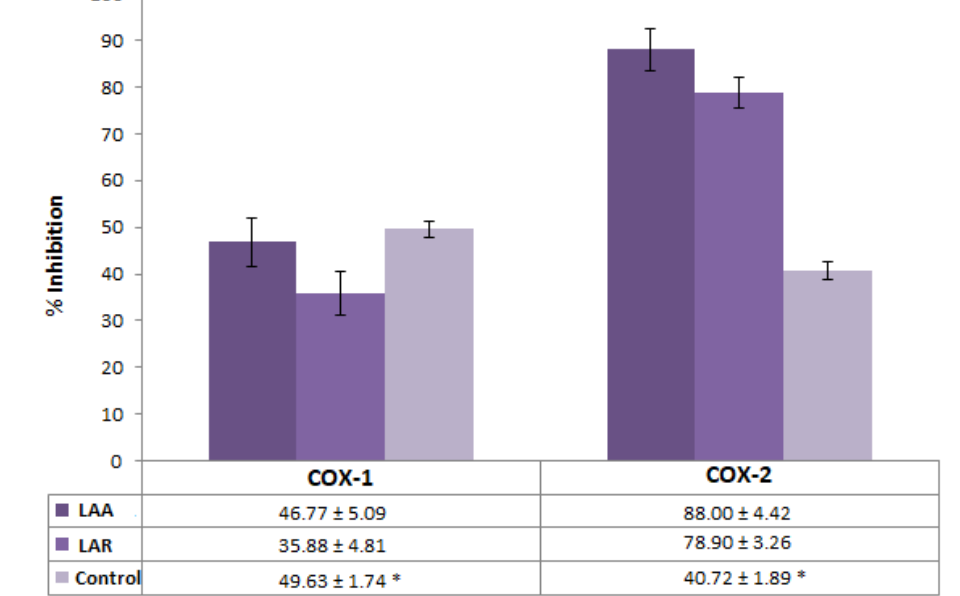
Figure 4. In vitro COX-1/2 inhibitory activities of Lunaria annua methanolic extracts (LAA and LAR, 50 μg/mL). Positive controls: indomethacin (1.25 μM) for COX-1, NS-398 (5 µM) for COX-2. Data (% inhibition) presents the results of two independent experiments (mean ± SD). * the results for positive controls are as in K ATANIĆ et al. (2016) since it was part of the same study.